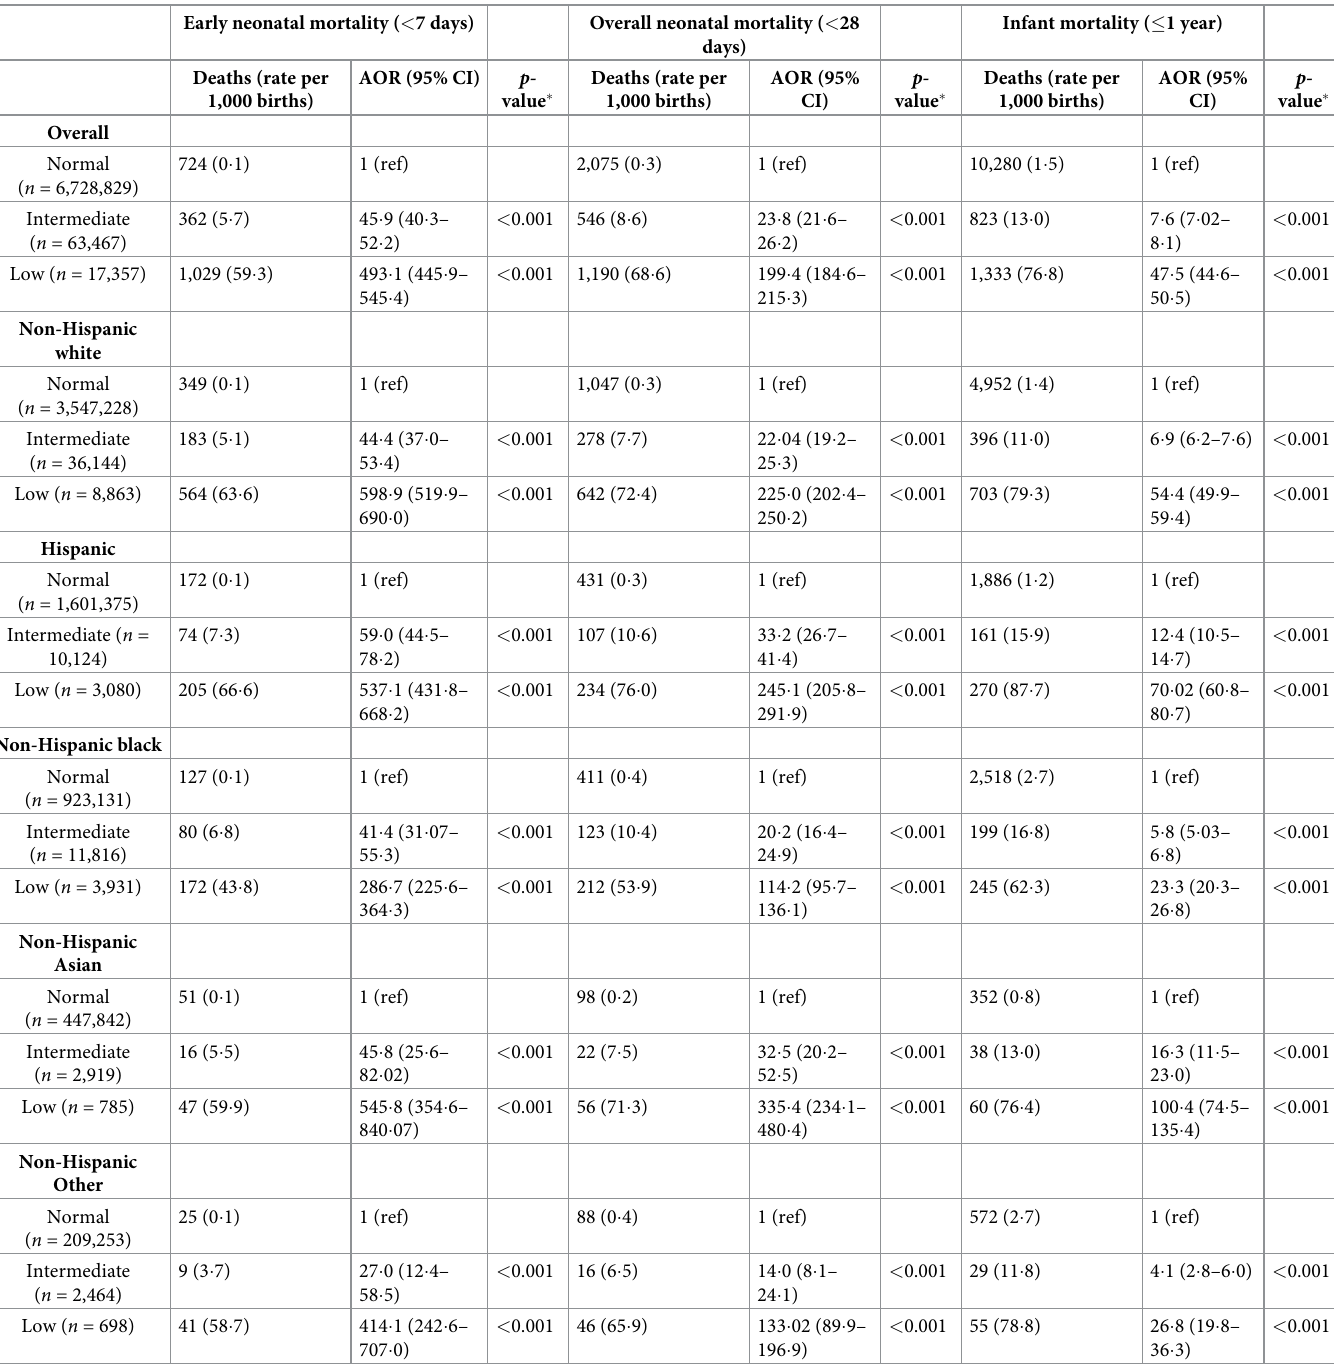
Table 3. AORs for early neonatal AU : AbbreviationlisthasbeencompiledforthoseusedinTable 3 : Pleaseverifythatallentriesarecorrect : mortality, neonatal mortality, and infant mortality in relation to Apgar score category, stratified by maternal race